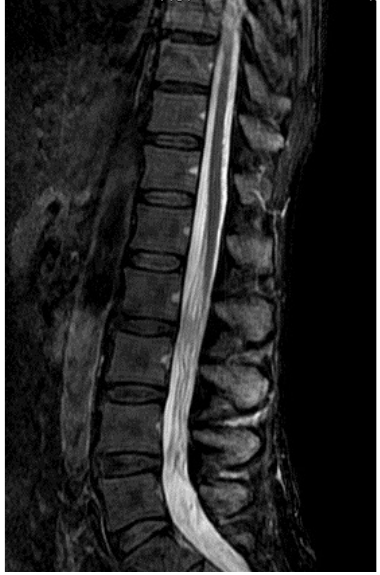
Figure 2. Magnetic resonance imaging of spinal cord (T2 image): pathological tis- sue infiltrating cauda equine, mainly in the vertebral body of L3, and interverte- bral space between